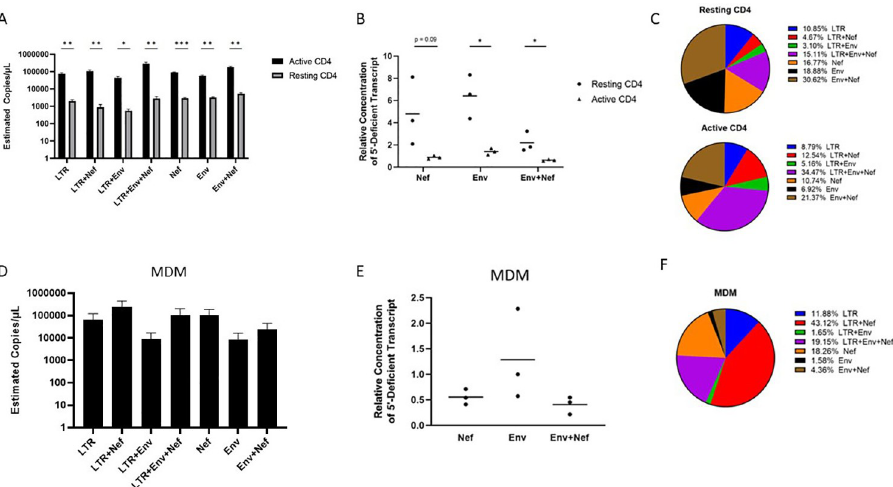
Fig 2. CD4+ T cells and MDMs express aberrant HIV-1 RNAs. (A) Multiplex RT-ddPCR was performed on RNA prepared from unstimulated and activated CD4+ T cells infected with HIV-1 NL4-3 by spinoculation for 90 minutes at an MOI of 0.02 and incubated for 72 hours prior to RNA isolation. HIV-1 infection was limited to a single round by addition of 10 μ M saquinavir 30 minutes after spinoculation. Activated CD4+ T cells were cultured with anti-CD3/ CD28 beads for 72 hours prior to spinoculation. Estimated copies/ μ L for transcripts were calculated with the QuantaSoft droplet reader software after manual gating of multiplex RT-ddPCR data (See S3 Fig) and dilution factor correction. (B) Ratios of HIV 5’UTR defective transcripts relative to transcripts with intact 5’UTRs for resting and activated HIV infected CD4+ T cells. (C) Frequencies of detected HIV transcripts as a percentage of all transcripts quantified by multiplex RT-ddPCR for resting (top) and CD3/CD28 activated CD4+ T cells. (D) Multiplex RT-ddPCR performed with RNA from HIV-1 NL43-BaL infected MDMs. MDMs were infected with HIV-1 NL43-BaL at an MOI of 0.01 for 4 hours by adding virus directly to adherent cell cultures for 48 hours prior to RNA isolation. (E) Ratios of 5’UTR defective transcripts relative to transcripts with intact 5’UTR for HIV infected MDMs. (F) Frequencies of HIV-1 transcripts as a percentage of all transcripts quantified by multiplex RT-ddPCR for HIV infected MDMs. Data represent three independent experiments using cells from three donors. Resting and activated CD4+ T cell sample data are donor matched. Bars represent standard error of the mean. Significance values were generated using multiple unpaired Two-tailed T tests. � denotes p < 0.05; �� denotes p < 0.01, and ��� denotes p < 0.001.